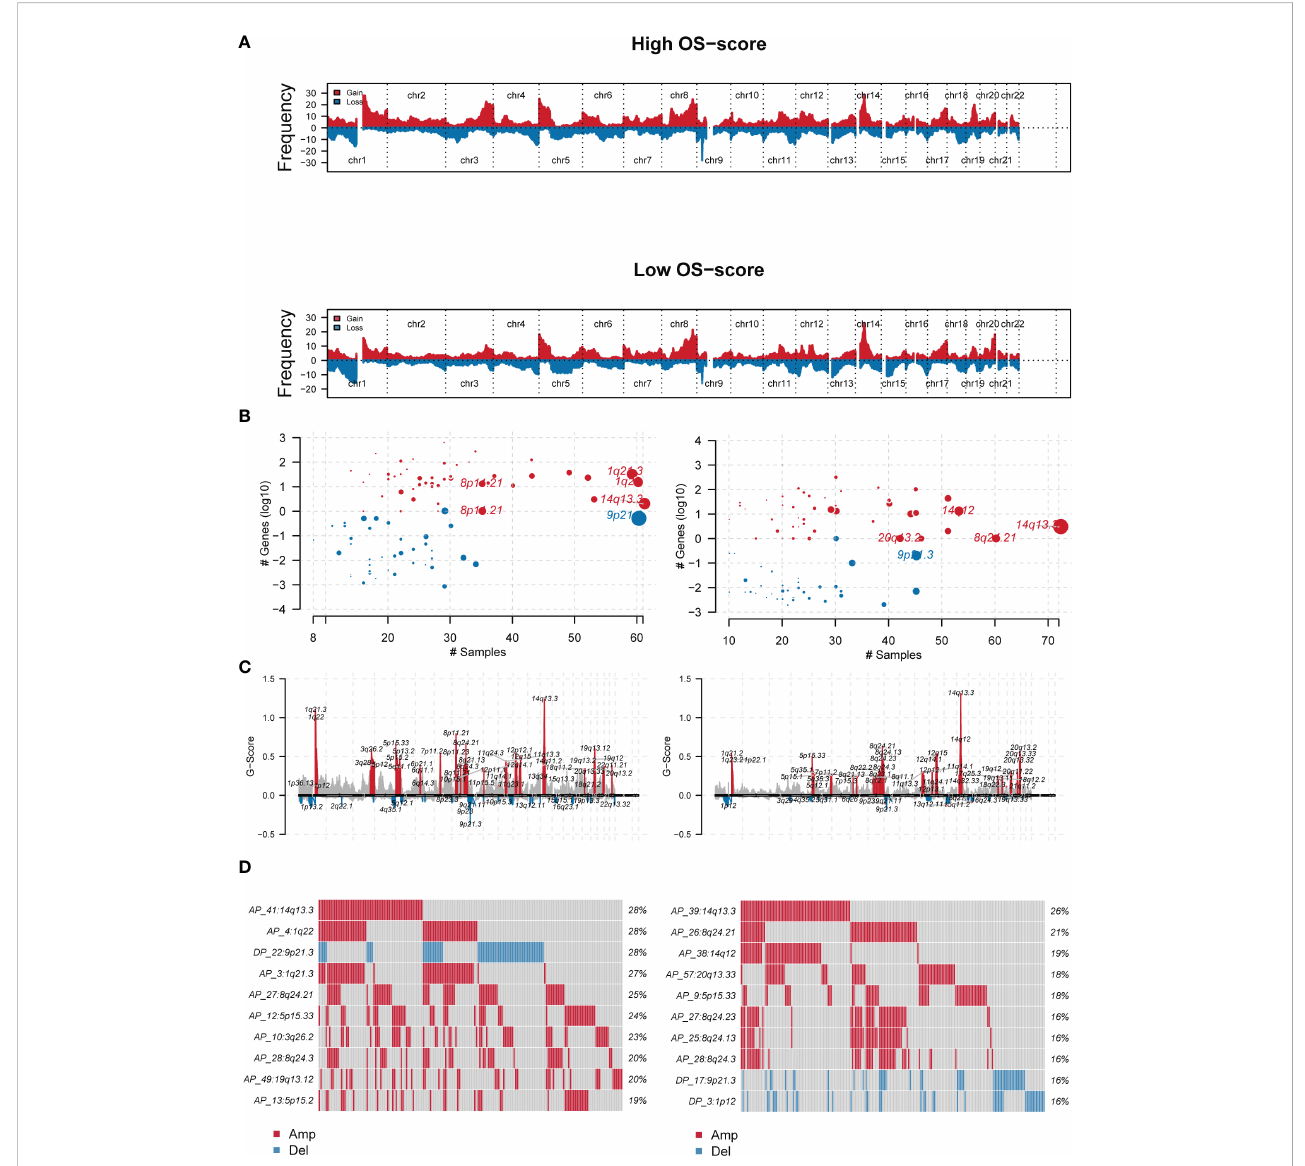
FIGURE 5 The genomic mutation analysis of the established OS-signature for LUAD. (A) Genomic characterization landscape of groups with high OS-scores or low OS-scores. (B) Plots signi fi cantly altered cytobands as a function of number samples in which it is altered and number genes it contains. Size of each bubble is according to -log10 transformed q values. (C) A genomic plot with segments highlighting signi fi fcant Ampli fi cations and Deletion regions. (D) The detailed ampli fi cated or deleted CNV onco-plots of groups with high OS-scores or low OS-scores.